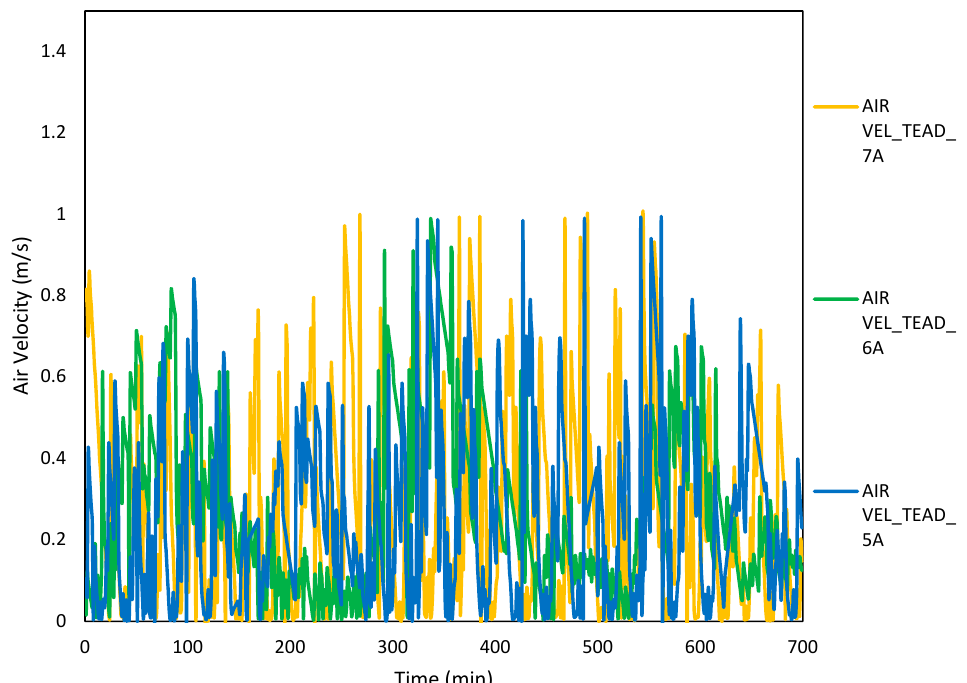
Figure 7. Variation of air velocity at different operating powers.